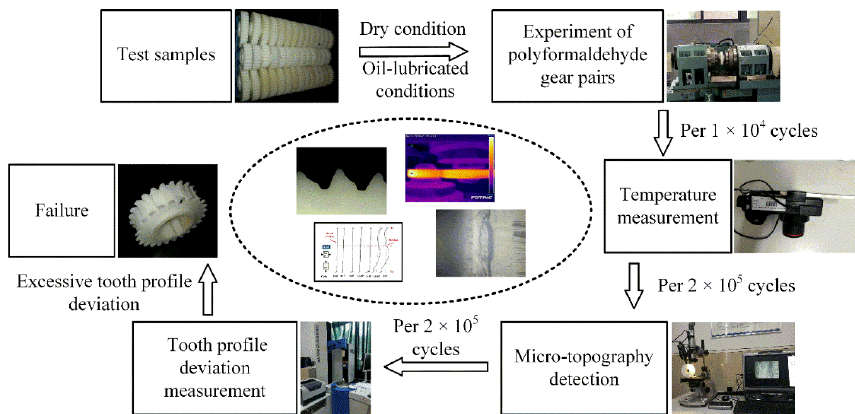
Fig. 4 Test procedure.